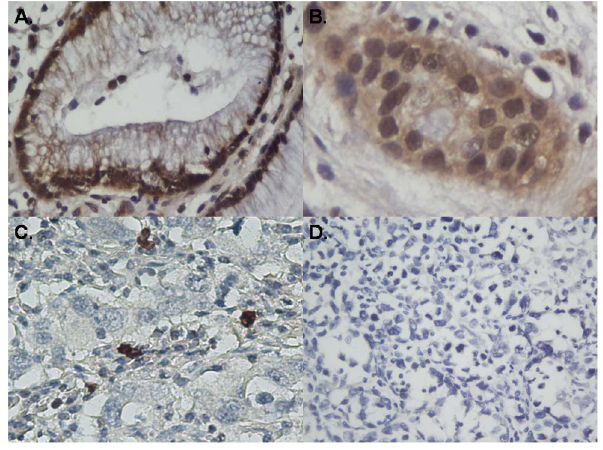
Figure 1. Decreased mRNA expression of GATA3 in gastric cancer tissues as assessed by real time quantitative PCR (n=38, P=0.0014). T=Tumor, N=Normal.